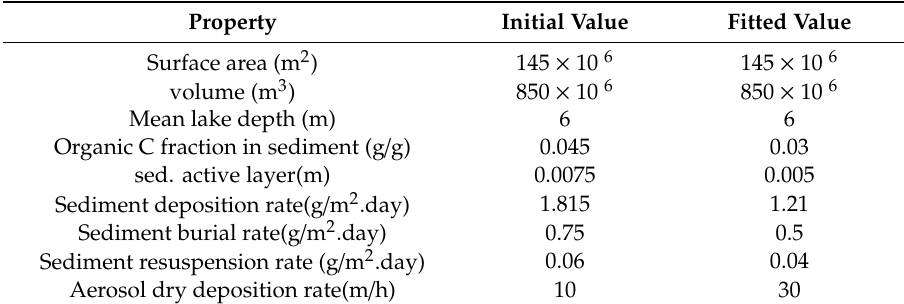
Table 2. Environmental properties used in the model